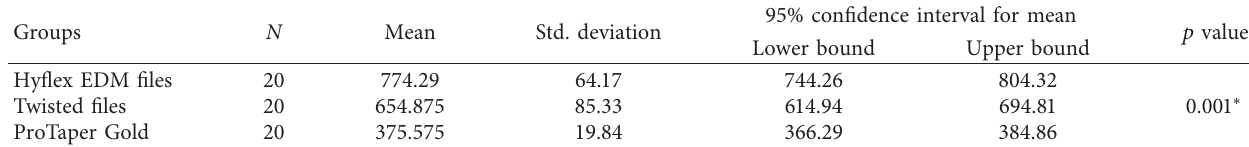
Table 1: Comparison of no. of cycles required for fracture among study groups using the one-way ANOVA test. Groups